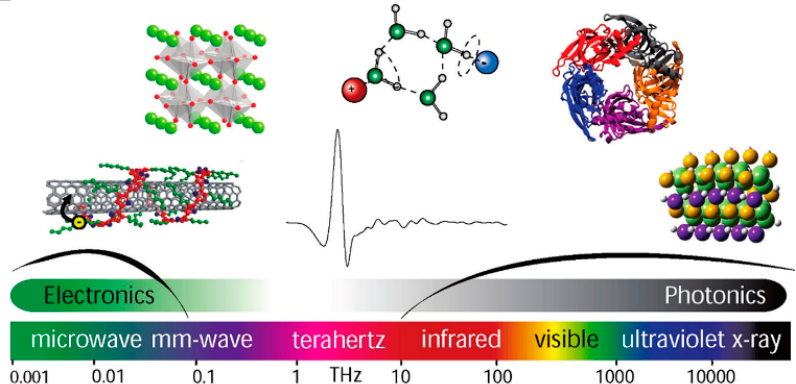
Figure 1. Classification of commonly used explosives.